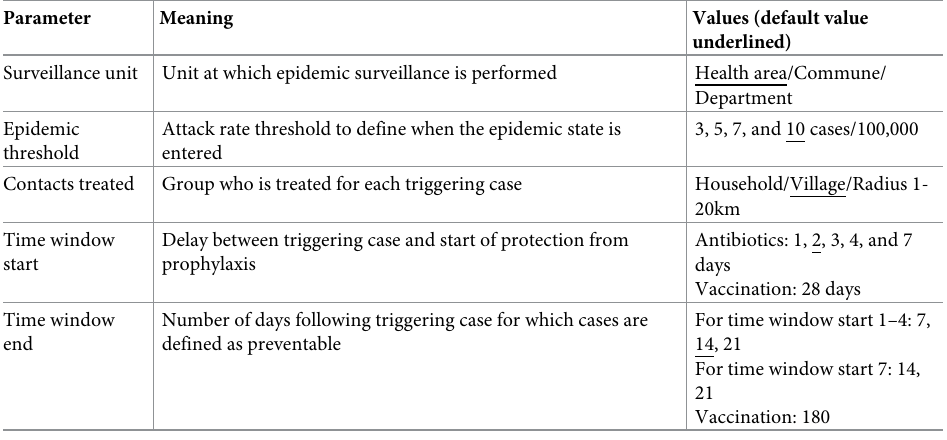
Table 2. Parameters, meanings, and values considered.